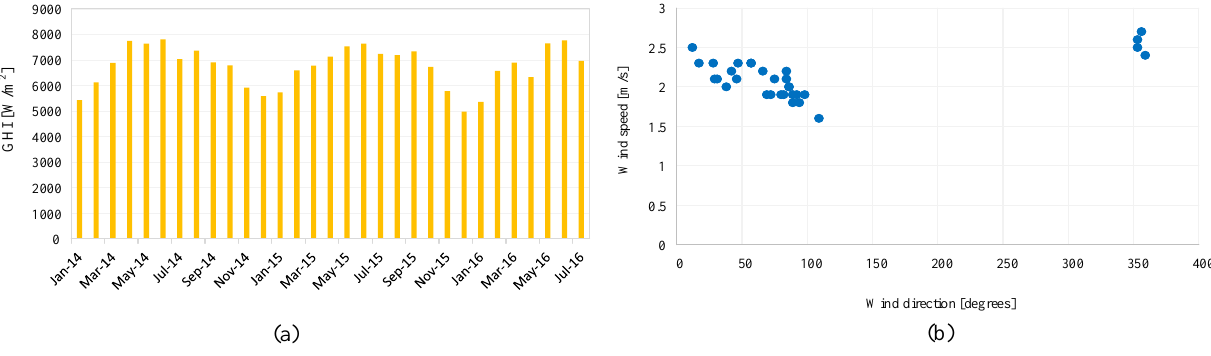
Figure 3. Normalization energy sources data at the Najran university. ( a ) The global horizontal irradiance in Wh/m 2 . ( b ) The average wind speed in [m/s] vs. wind